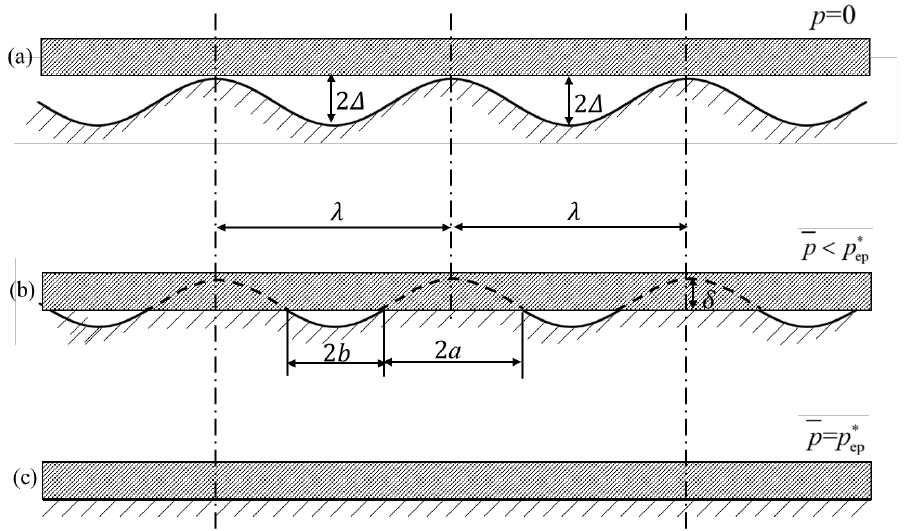
Figure 5. Simulated microscopic contact process between axisymmetric sinusoidal micro-convex body and rigid plane in the xoz cross section. ( a ) Initial contact; ( b ) partial contact; ( c ) complete contact.